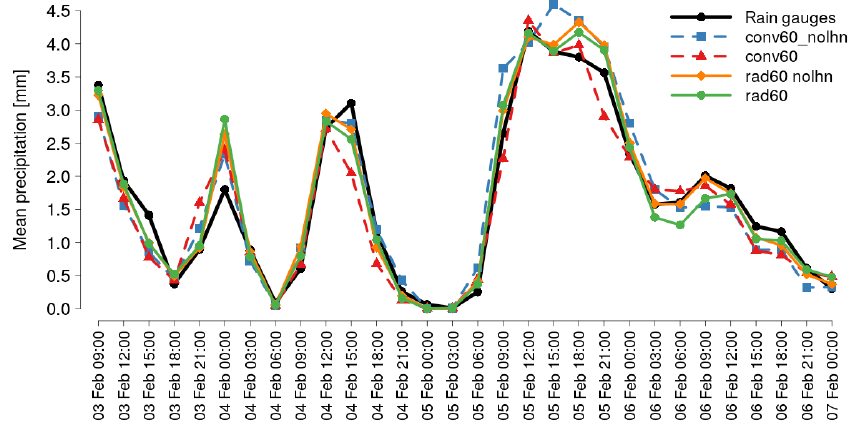
Figure 3. Areal average 3-hourly precipitation for rain gauges (black) in the verification area shown in dark grey in Fig. 2 and for the corresponding model forecast, during the assimilation procedure, relative to experiments conv60_nolhn (dashed blue line), conv60 (dashed red line), rad60_nolhn (solid orange line) and rad60 (solid green